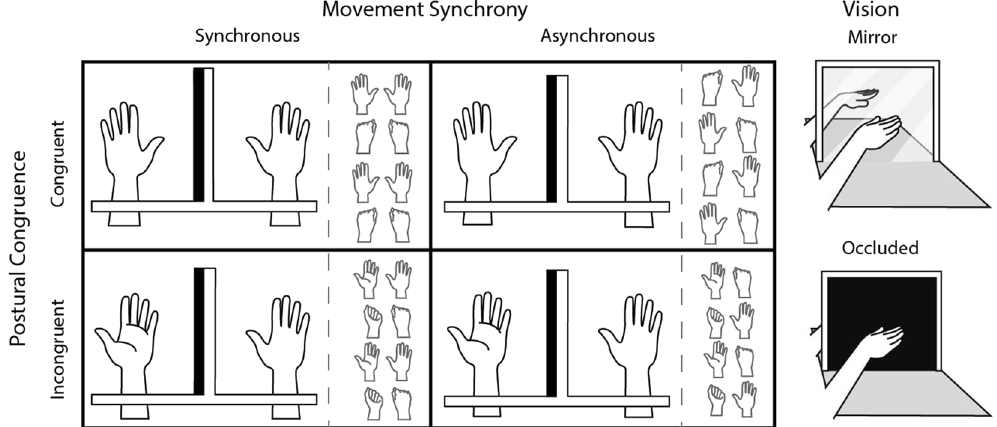
Figure 1. Top-down view of hand postures and movement (left) and vision conditions (right) in Experiment 1. Left: Each box represents a trial type in the mirror vision condition. Participants placed their left hand behind the mirror and the right hand in front of the mirror, with hands in either congruent (top) or incongruent (bottom) postures. Hand position, shown at each half beat of the metronome (starting at top) is shown on the right side of each box. Movements were either synchronous (left) or asynchronous (right). Right: Participants viewed the reflection of their right hand in the mirror vision condition (top) and a black sheet in the occluded vision condition